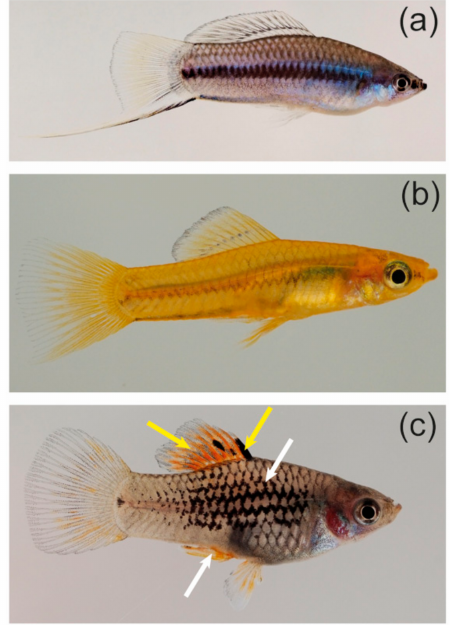
Figure 2. Color patterns of Xiphophorus fish. ( a ) Blue male with a yellow tailfin of Xiphophorus nigrensis . Total length of the fish: 6 cm; ( b ) Yellow male of Xiphophorus pygmaeus . Total length of the fish: 3 cm; ( c ) Xiphophorus maculatus male with two different macromelanocyte and red-yellow (RY) patterns. White arrows: Y-chromosomal macromelanocyte stripes with linked RY pattern in the anal fin. Yellow arrows: X-chromosomal macromelanocytes and linked RY pattern in the dorsal fin. Total length of the fish: 3